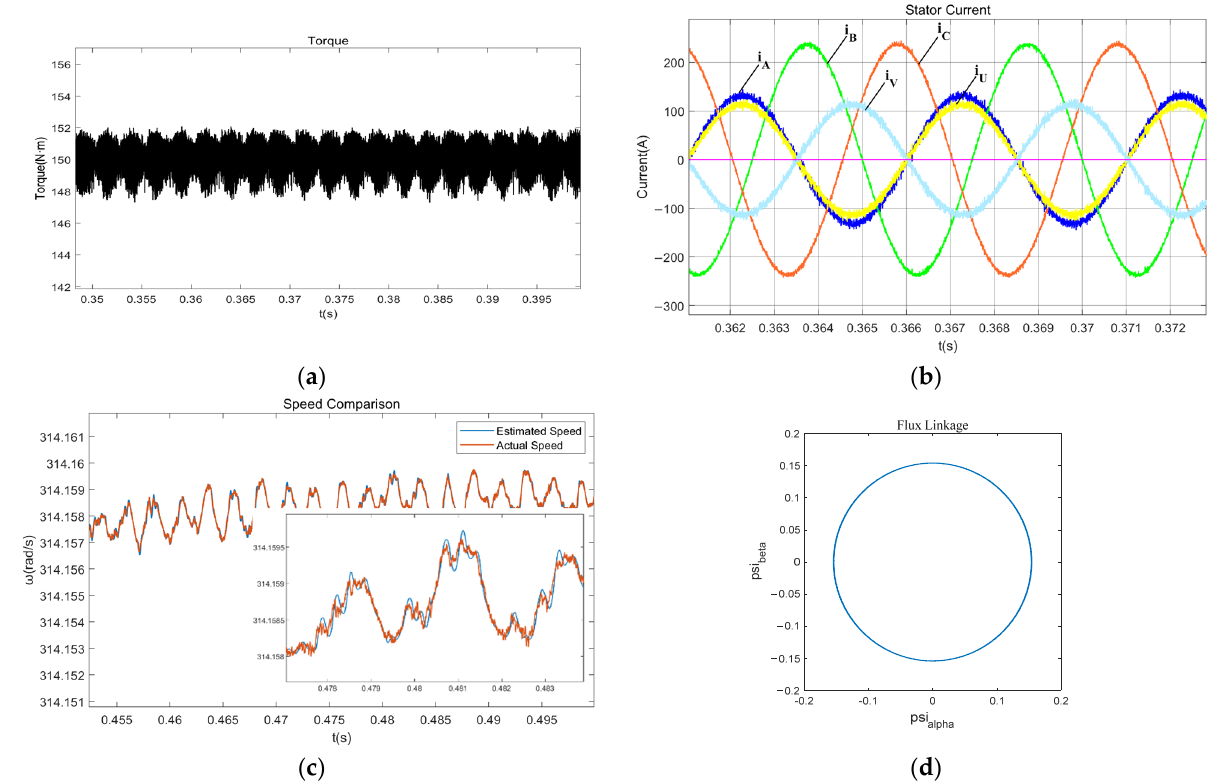
Figure 7. Simulation results under fault-tolerant control. ( a ) Torque; ( b ) phase current; ( c ) speed comparison; ( d ) flux.